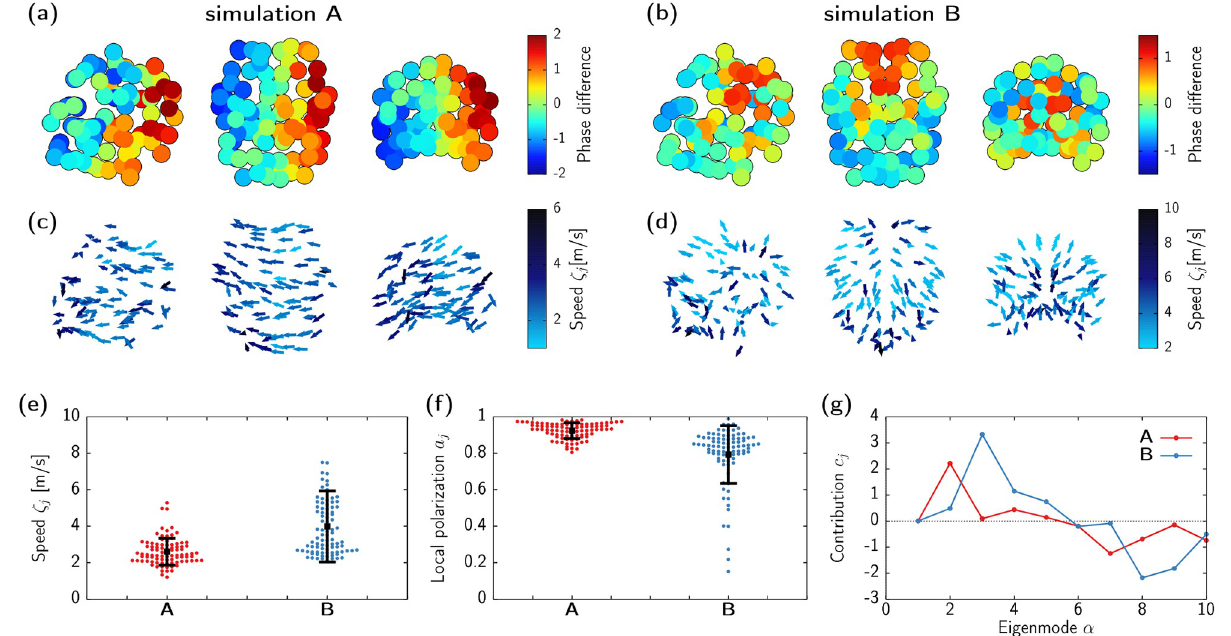
Fig 3. Multistability between different types of periodic travelling waves. (a,b) Difference between each node’s phase ϕ corresponding to simulations with p = 230 and � = 50, in the spatial representation of the brain network (from left to right: frontolateral, superior, and frontal views). Panels (a) and (b) correspond to two different initial conditions. (c,d) Propagation direction vectors ζ patterns of (a) and (b). Color indicates the propagation speed ν correspond to individual brain regions. Black squares show the average over the entire network, and error bars indicate standard deviation. (g) Contribution of each structural connectivity eigenmode to the growth rate of the perturbations in simulations A and B (see Eq (29) in Methods).